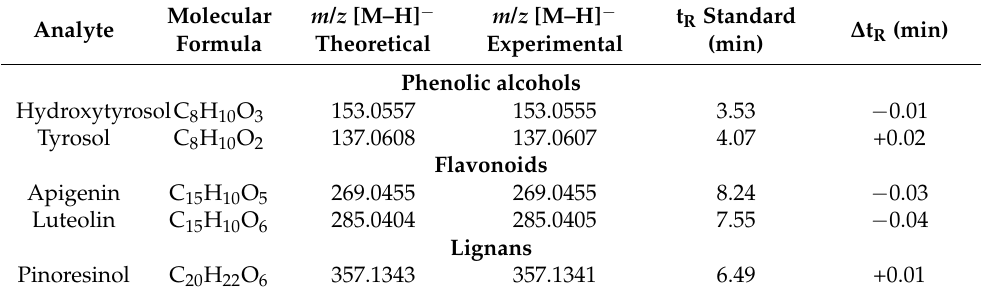
Table 1. Results of target screening for EVOOs.